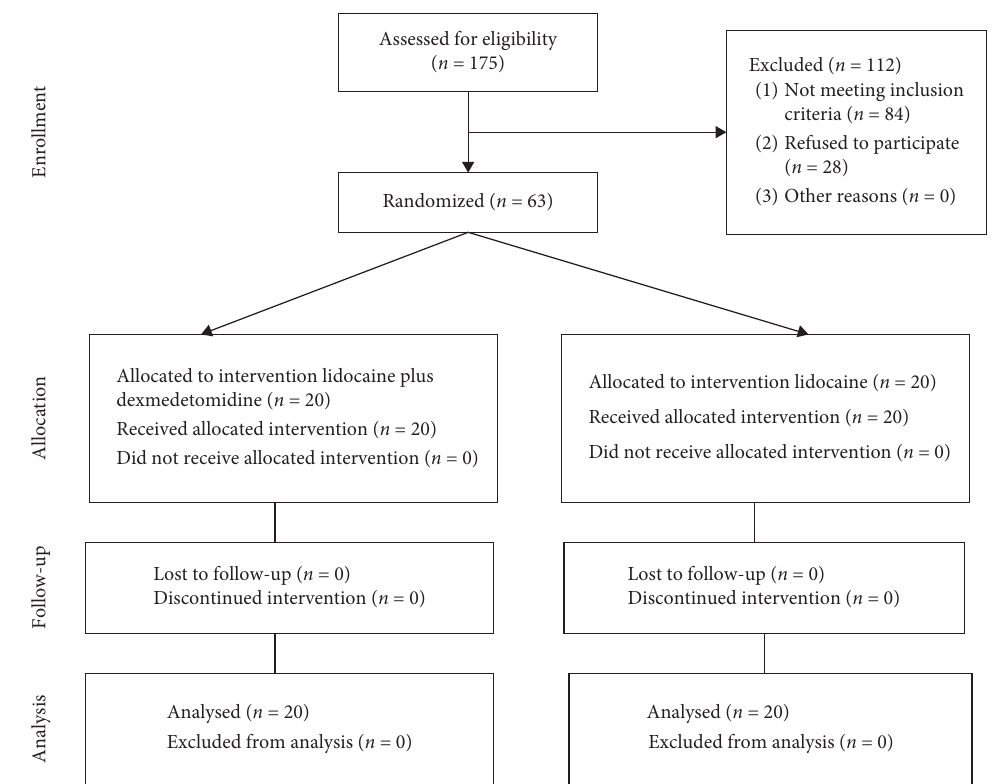
Figure 1: CONSORT flow diagram of the study